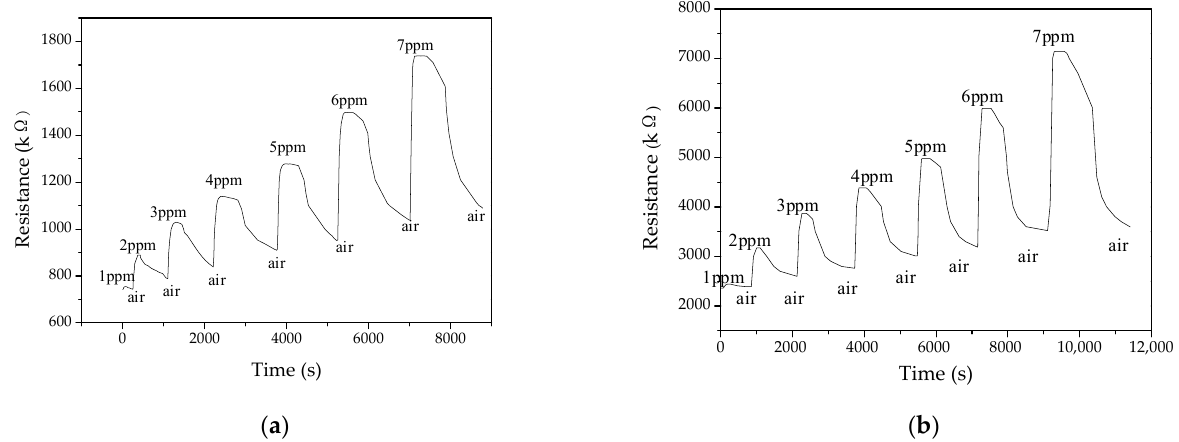
Figure 8. Gas sensor response curves for different ammonia concentrations. ( a ) PANI; ( b ) PANI/SnO 2 .